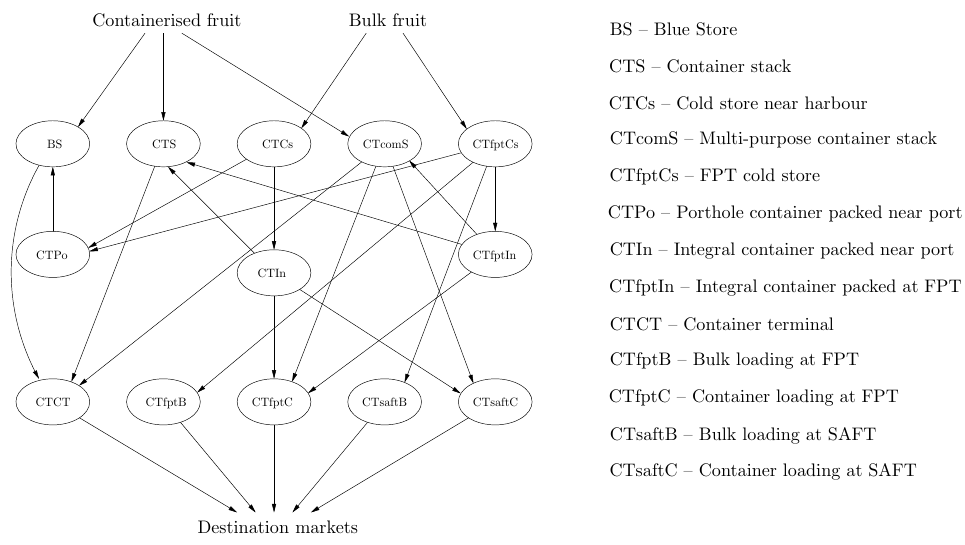
Figure 5: Simplification of a part of the export infrastructure network representing the possible flow of fruit through the infrastructure components in the port of Cape Town. Note that the intake and discharge nodes for all the elements of this part of the network have been condensed into single nodes, for the sake of